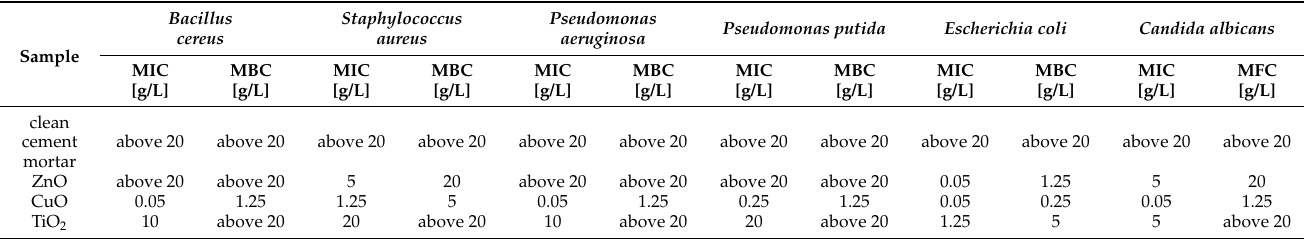
Table 5. Determination of antimicrobial properties of the studied materials (expressed as MIC and